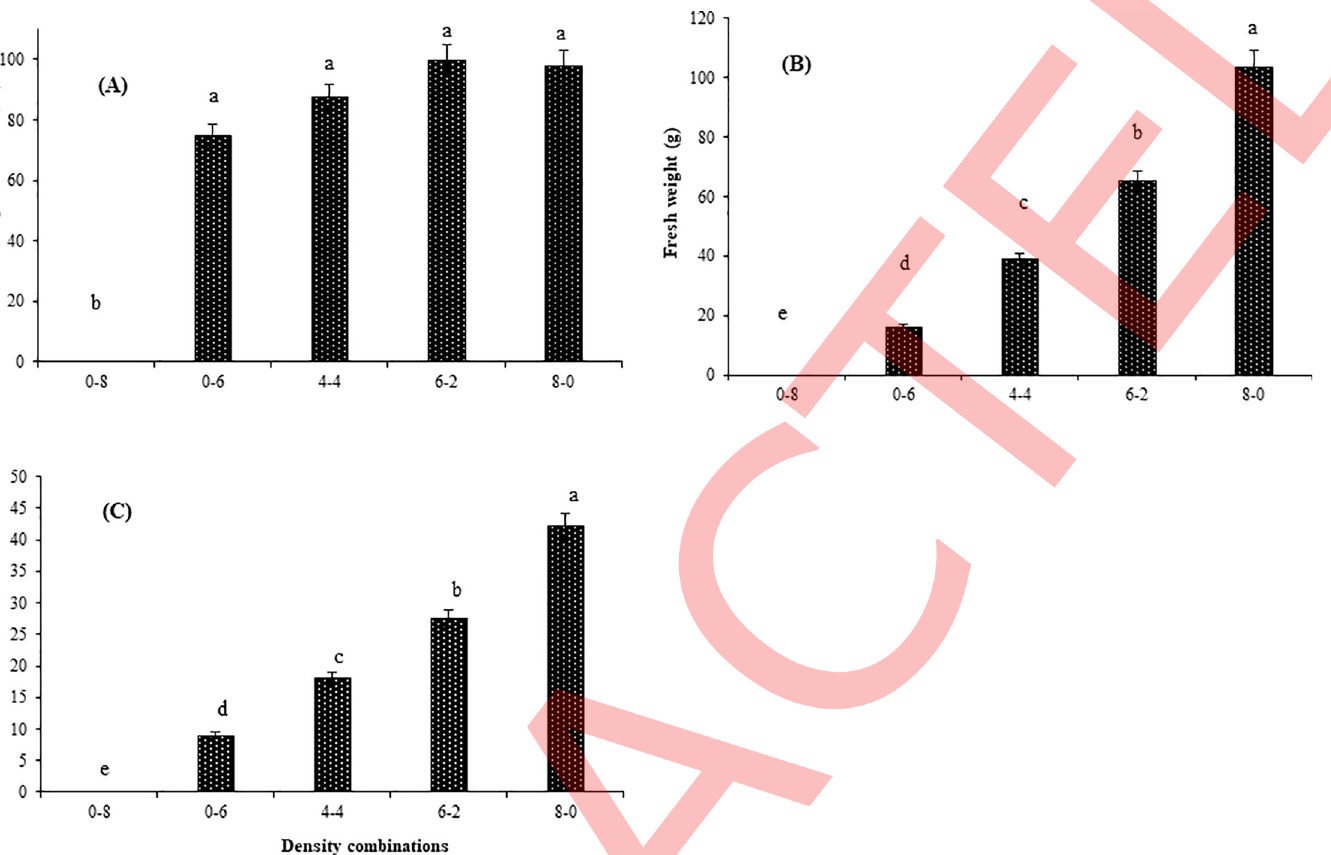
Fig 4. The effect of different wild oat and wheat density combinations on seed germination (A), fresh weight (B) and dry weight (C) of wild oat. https://doi.org/10.1371/journal.pone.0240944.g004 weight at 2–4 leaf growth stage indicated that wild oat gives better response to applied herbi- cides at initial stage compared to later stages. The density of weeds and crop plants significantly affect the seed germination and growth traits of both species. The higher seed density of weed species negatively affect the seed germi- nation and subsequent growth of crop plants. Moreover, higher seed density results in higher Table 4. Analysis of variance for and fresh and dry biomass of wild oat under different post-emergence herbicides’ application. Source DF Sum of squares Mean squares F value P value Fresh biomass Growth Stage (G)